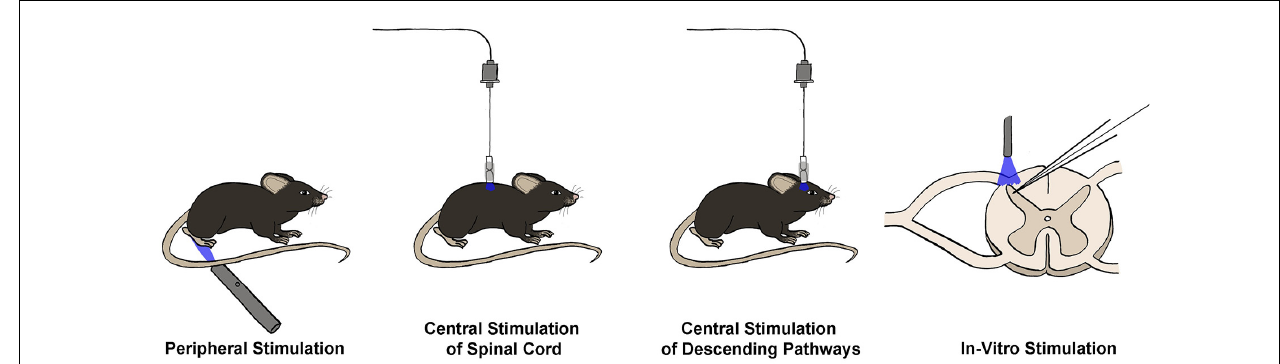
FIGURE 2 | Techniques for optogenetic interrogation of spinal circuitry. Opsins may be stimulated in four main ways to interrogate spinal circuitry. First, opsins can be expressed in primary afferent terminals, and peripheral stimulation can be used to stimulate or silence primary sensory neurons and observe real-time changes in behavioral output in vivo . Similarly, opsins can be expressed in neuronal populations within the spinal cord or brain, allowing for in vivo central stimulation of either spinal cord neuron populations or neurons involved in descending modulation, respectively. Finally, opsins may be expressed within primary afferents or spinal cord neuron populations, and then stimulation can occur in an in vitro slice preparation, often combined with electrophysiological recordings to measure the effect of activation or silencing of a given neuronal population on the excitability of the recorded neuron.